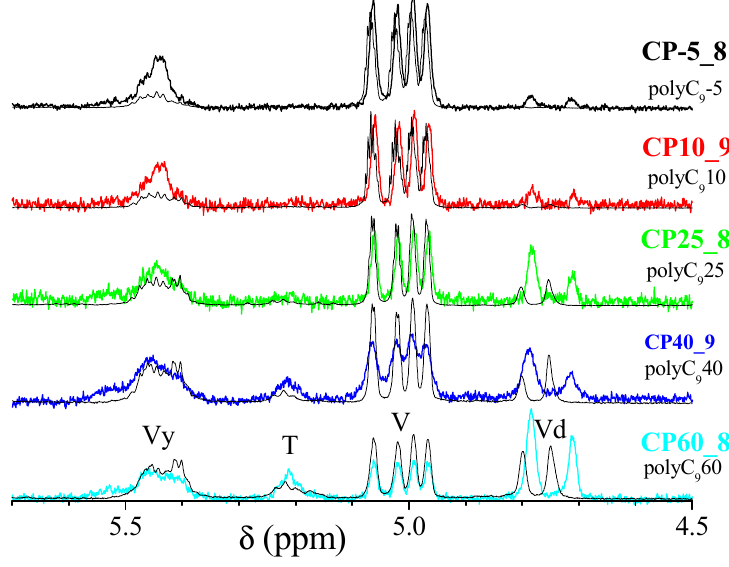
Figure 7. Olefinic window of 1 H NMR spectra for samples with comparable C 9 contents, obtained at different T pol . Spectra of corresponding polyC 9 samples are shown for comparison.